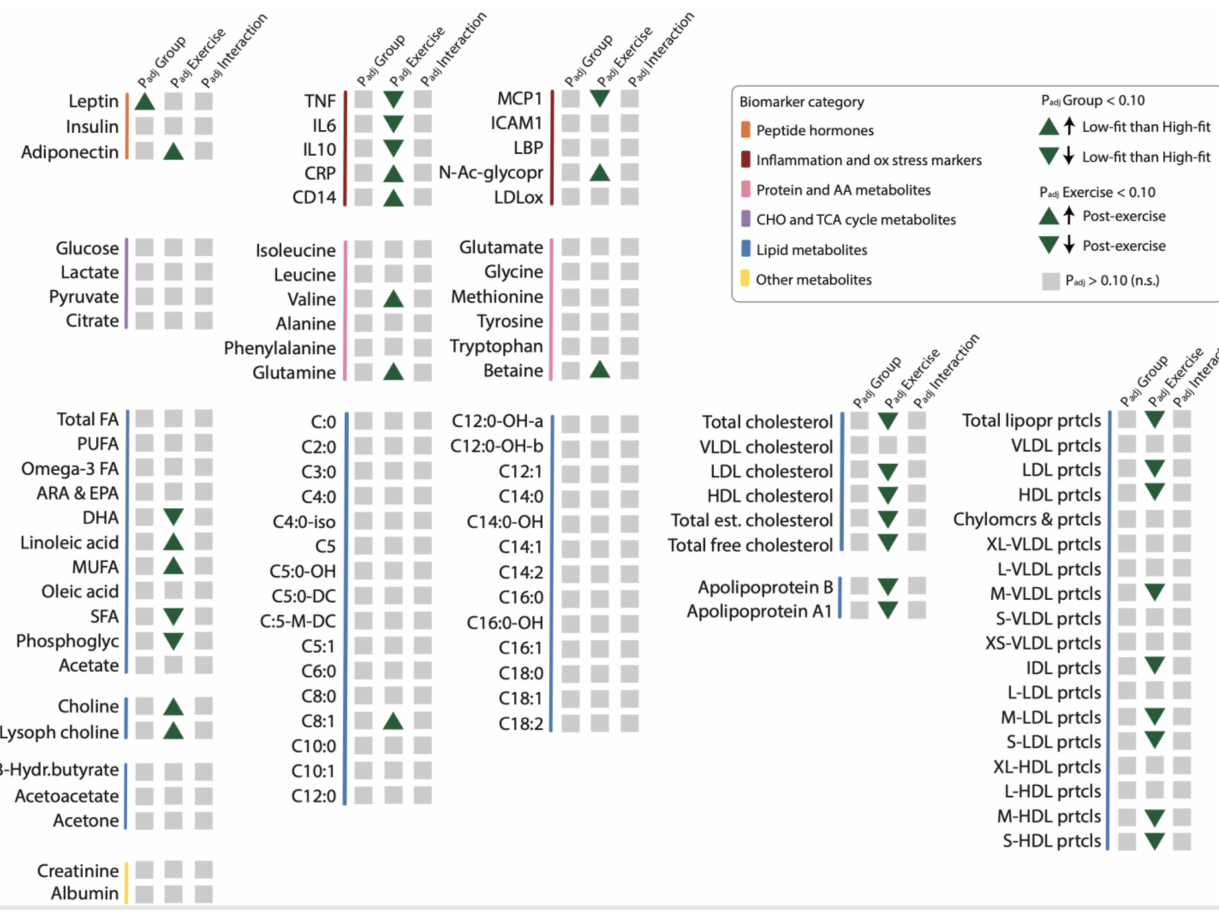
Figure 1. The effect of fitness level and a recent exercise bout on individual biomarker and metabolic parameter levels. Graphical summary representing the fitness level effect (P adj Group), recent exercise effect (P adj Exercise), and interaction effect (P adj Group*Exercise, shown as P adj Interaction) on individ- ual biomarker and metabolic parameter levels within each functional biomarker and metabolic param- eter category (indicated by colour). Significant fitness level effects (P adj group < 0.10) or recent exercise effects (P adj exercise < 0.10) are depicted by upward and downward green triangles that indicate the direction of the effect. Non-significant effects (P adj group, P adj exercise, or P adj group*exercise > 0.10) are depicted in grey squares (all interaction effects were not significant). The main effects (fitness level and recent exercise) and interaction effects were analysed using